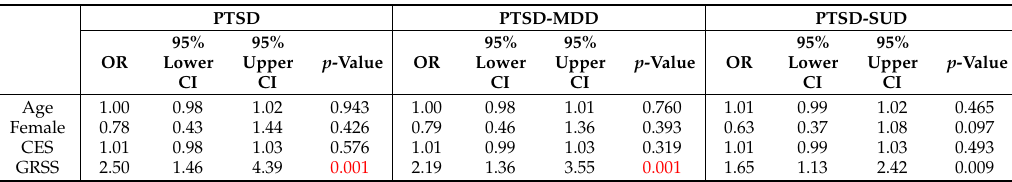
Table A3. Results using Genetic Risk Sum Score